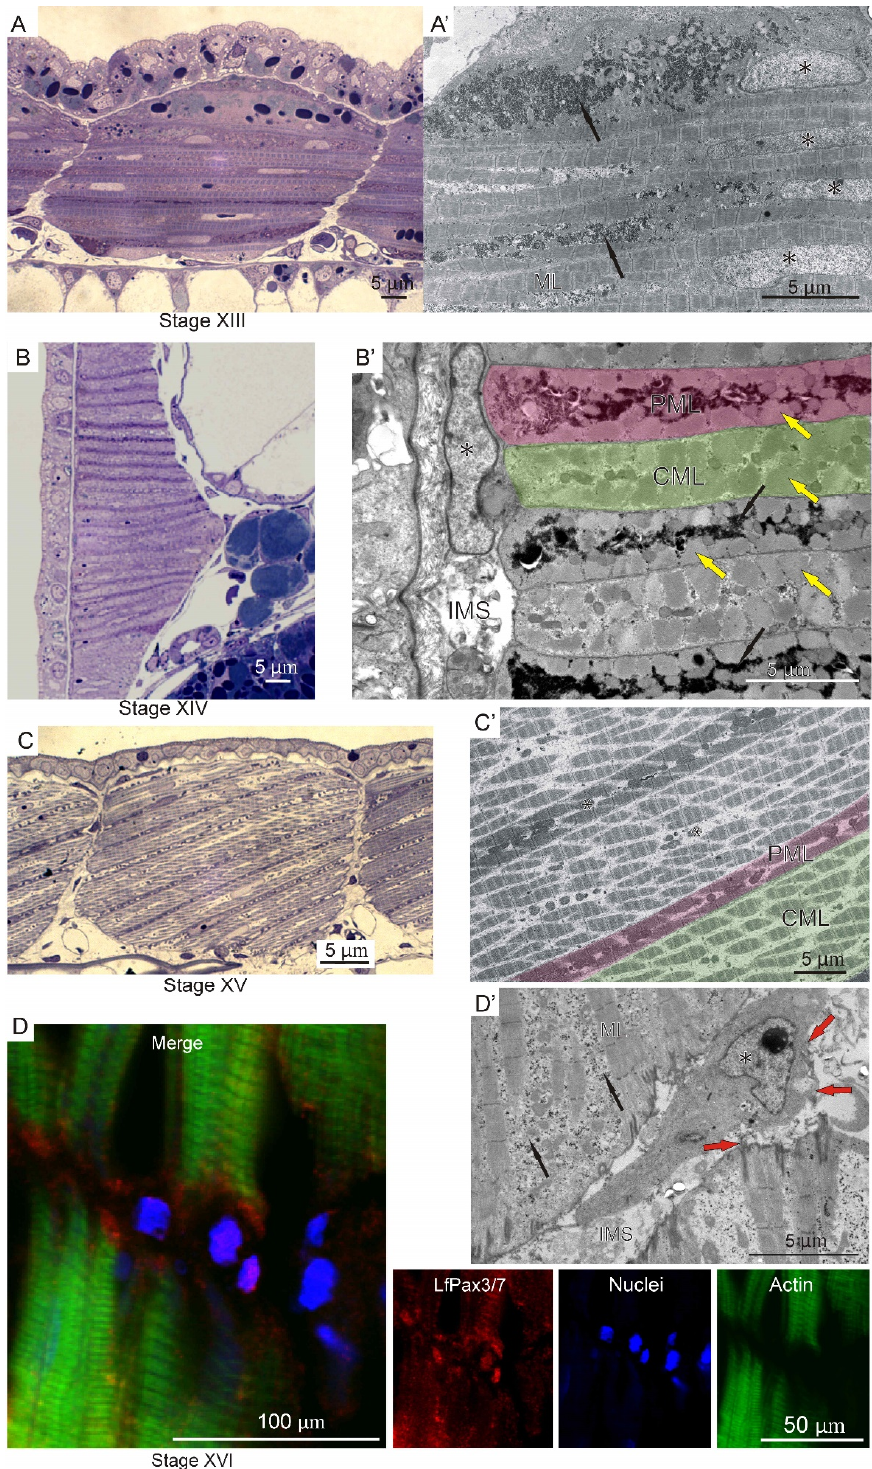
Figure 4. Formation of central and parietal muscle lamellae in the river lamprey ( L. fluviatilis ). Longitudinal ( A , C ) and cross sections ( B ) of trunk muscles stained with methylene blue. ( A’ – D’ ) Ultrastructure of skeletal muscles. ( D ) Confocal longitudinal section. LfPax3/7 (red), nuclei (blue), actin (green). Muscle lamellae (ML), glycogen granules (black, thin arrows), nuclei (*), parietal muscle lamellae (PML, colored in pink at ( B’ , C’ )), central muscle lamellae (CML, colored in green at ( B’ , C’ )), myofibrils (yellow arrows), intermyotomal space (IMS), collagen fibers (red